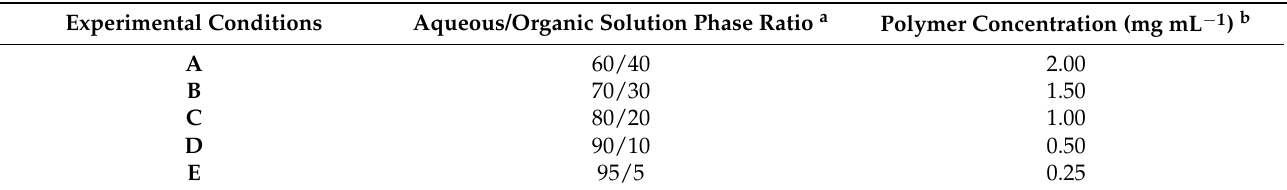
Table 3. Experimental preparation conditions of LDBCs self-assemblies by microfluidics: phase ratio values (aqueous